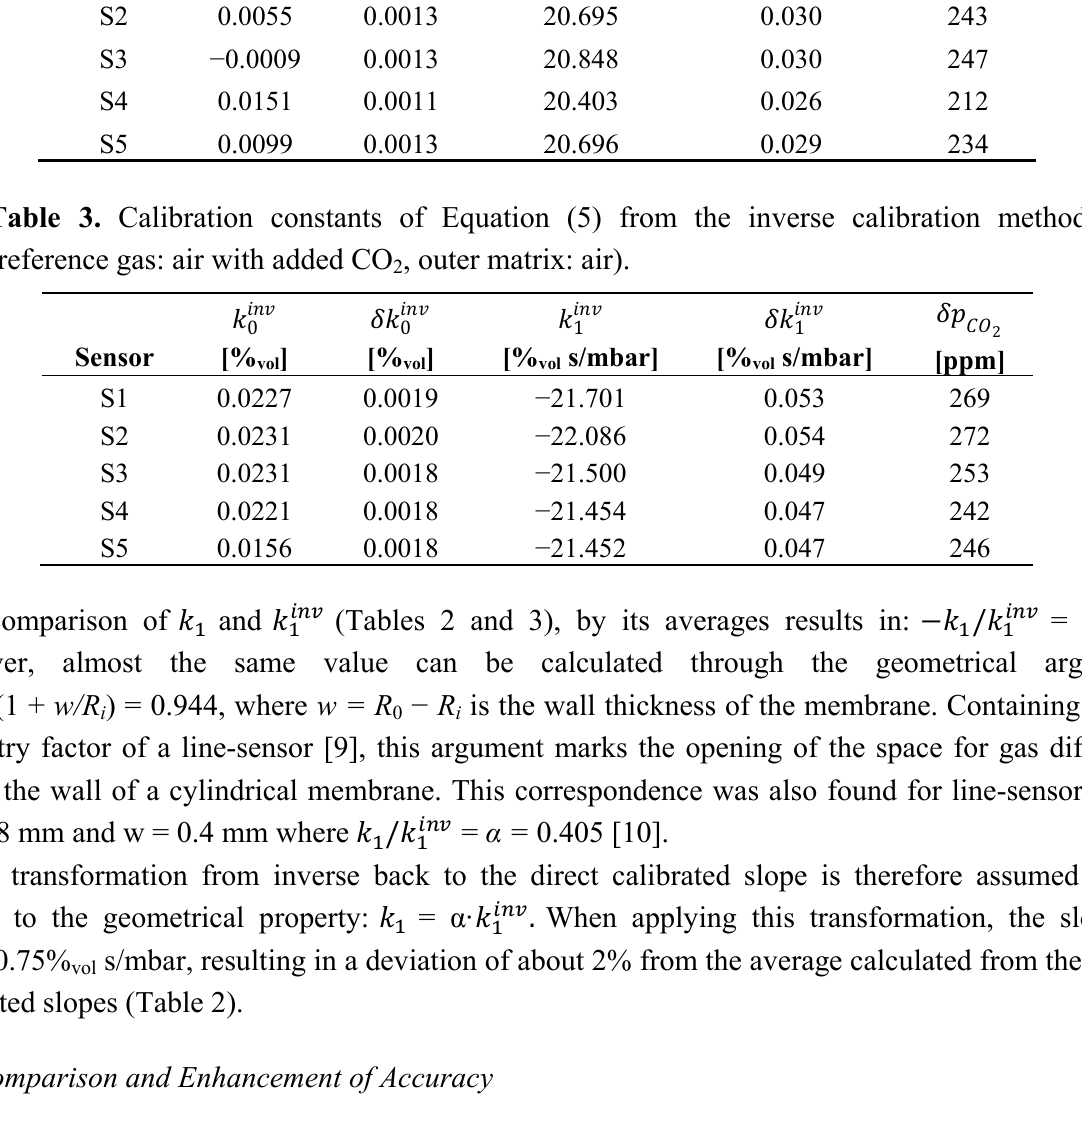
Table 2. Calibration constants of Equation (4) from the direct calibration (reference gas: air, outer matrix: air with added CO